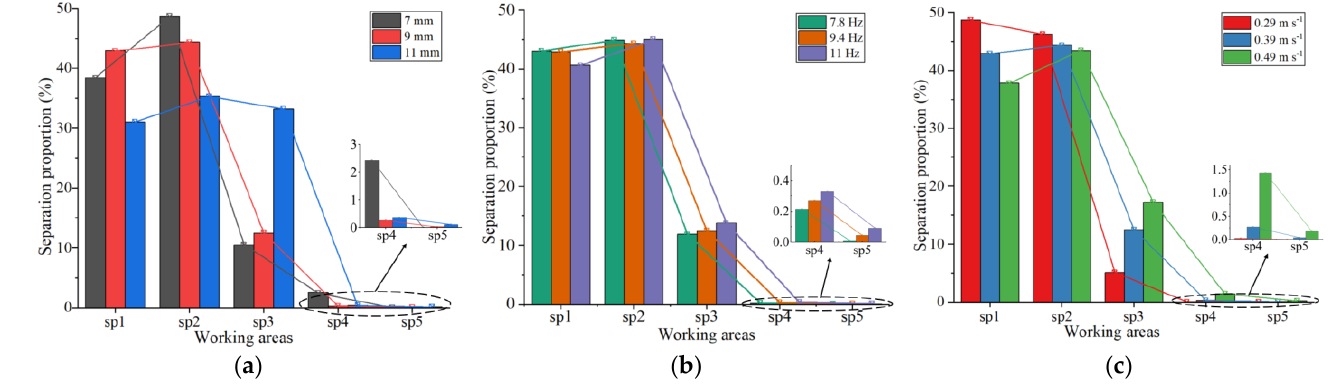
Figure 14. Effects of parameters on the separated proportion: ( a ) Amplitude; ( b ) Vibration frequency; ( c ) Forward speed.